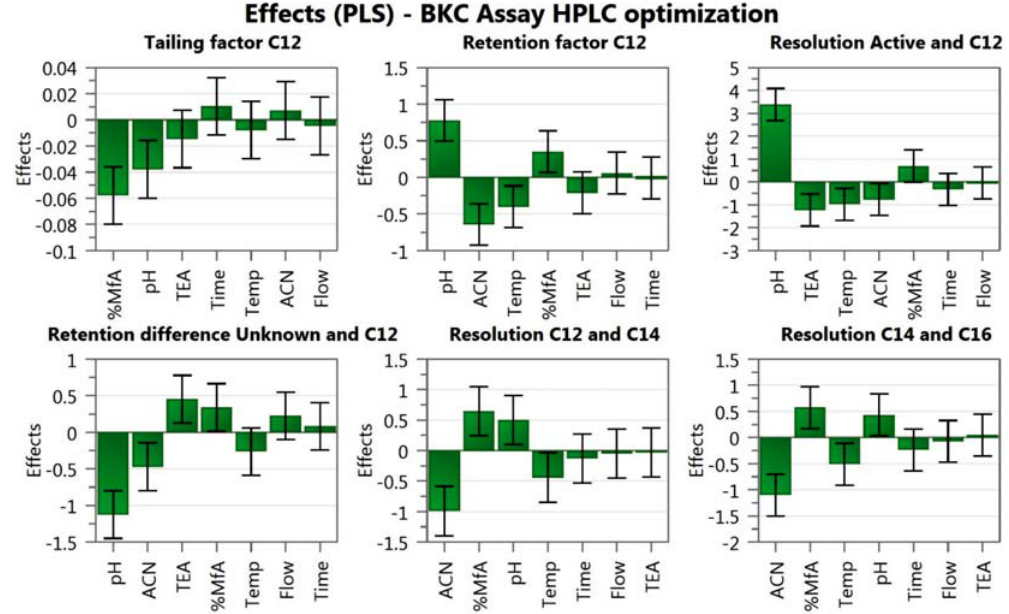
Figure 2. Main effects for all observed responses for HPLC method optimization for BKC assay